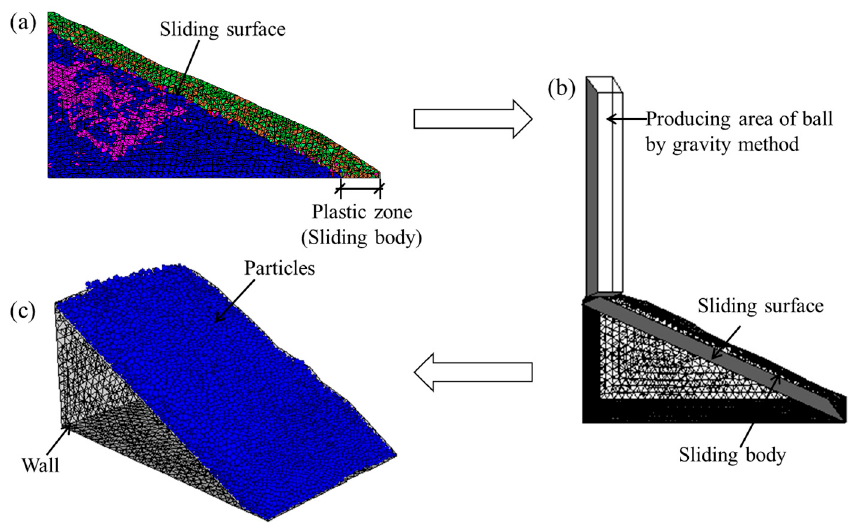
Figure 7. PFC 3D modeling for the Jinpingzi landslide: ( a ) FEM of the landslide; ( b ) The generation of wall model based on finite element model of the sliding bed; and ( c ) The generation of ball model in the sliding body.